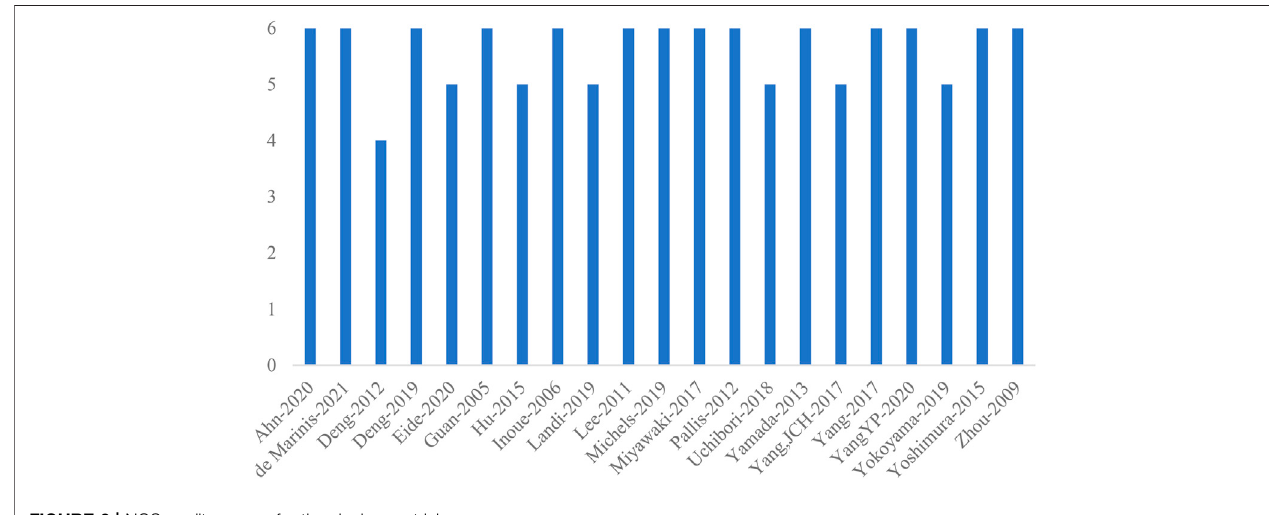
FIGURE 3 | NOS quality scores for the single-arm trials.